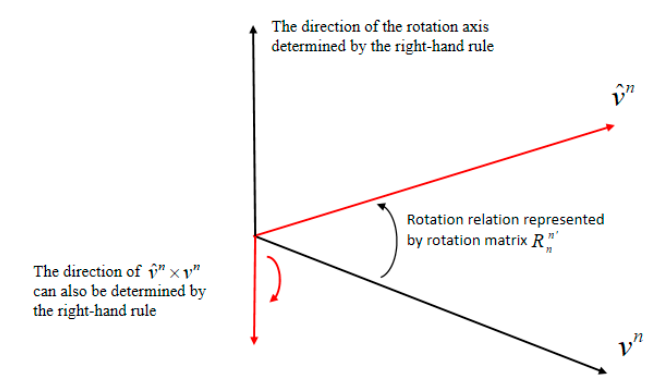
Figure 3. Schematic diagram of the rotation axis and error Lie algebra directions.